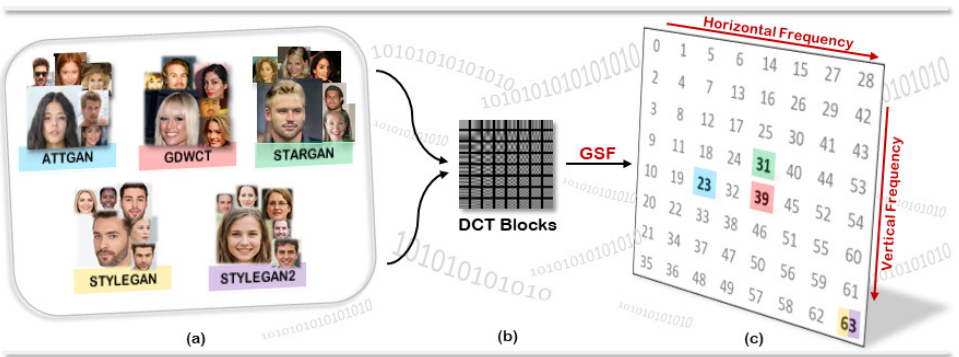
Figure 5. CTF-DCT approach: ( a ) Dataset used for our experiments; ( b ) Discrete Cosine Transform (DCT) of a given image at each 8 × 8 blocks; ( c ) GAN Specific Frequencies (GSF) that identify involved GAN